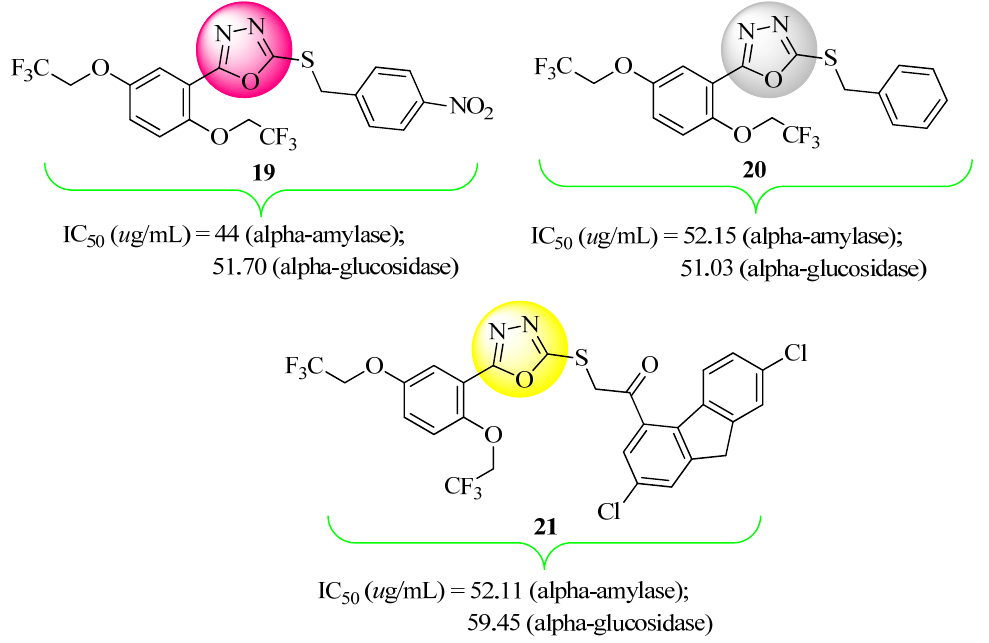
Figure 13. 1,3,4-Oxadiazole-2-thiol derivatives.